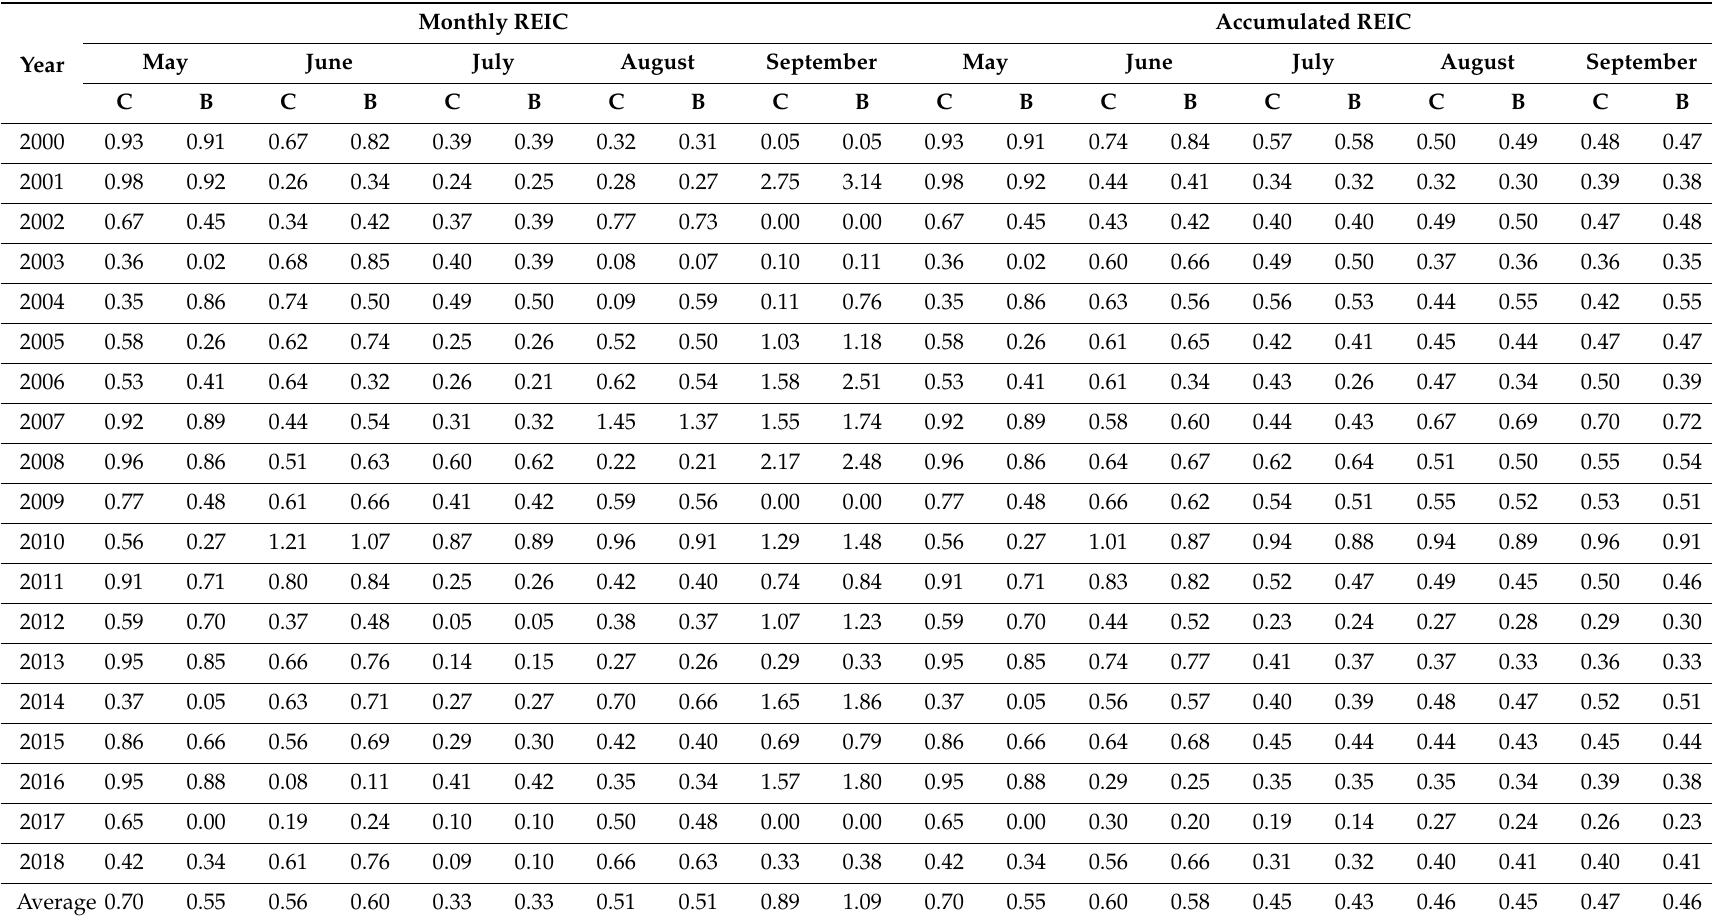
Table 5. Results of monthly REIC and accumulated REIC in Iowa,